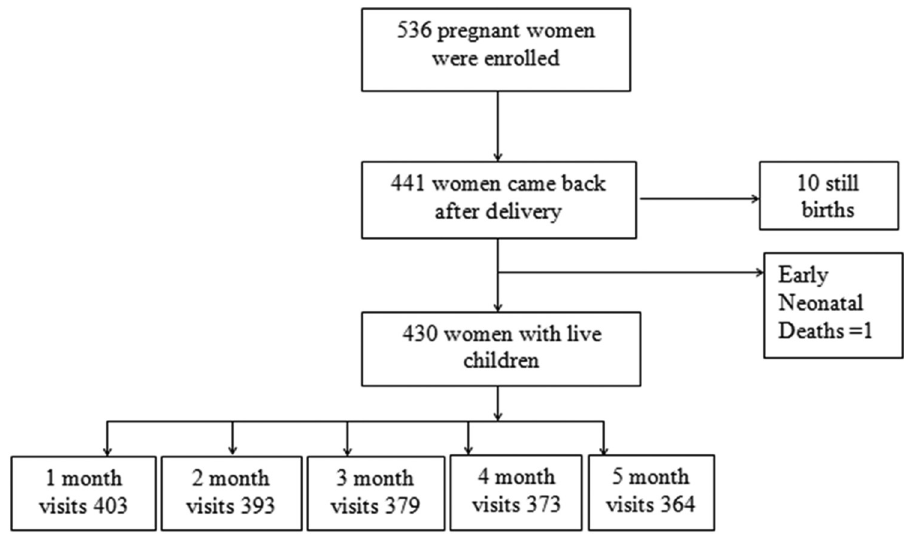
Figure 1: Flow chart of the study